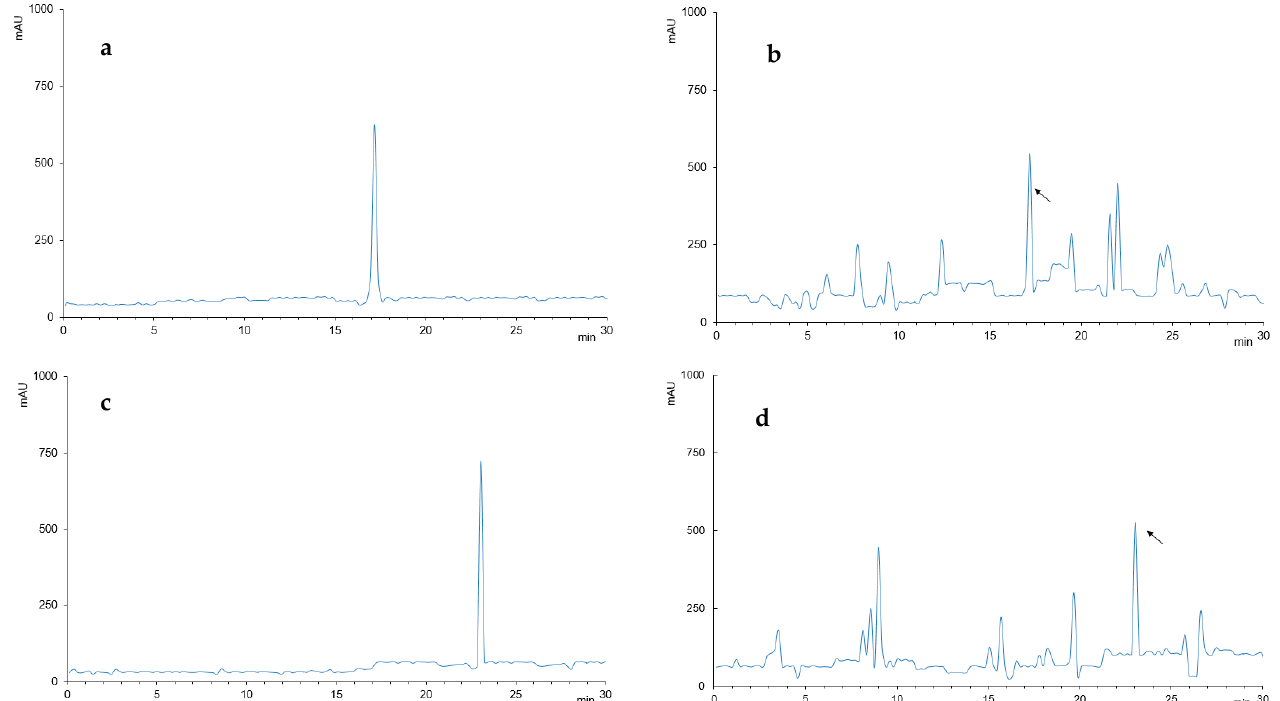
Figure 1. HPLC analysis of GTP, PPP, EP and PN. ( a ) EP, standard; ( b ) GTP, 1:5 mg/mL in water; ( c ) PN, standard; ( d ) PPP, 1:5 mg/mL in water.